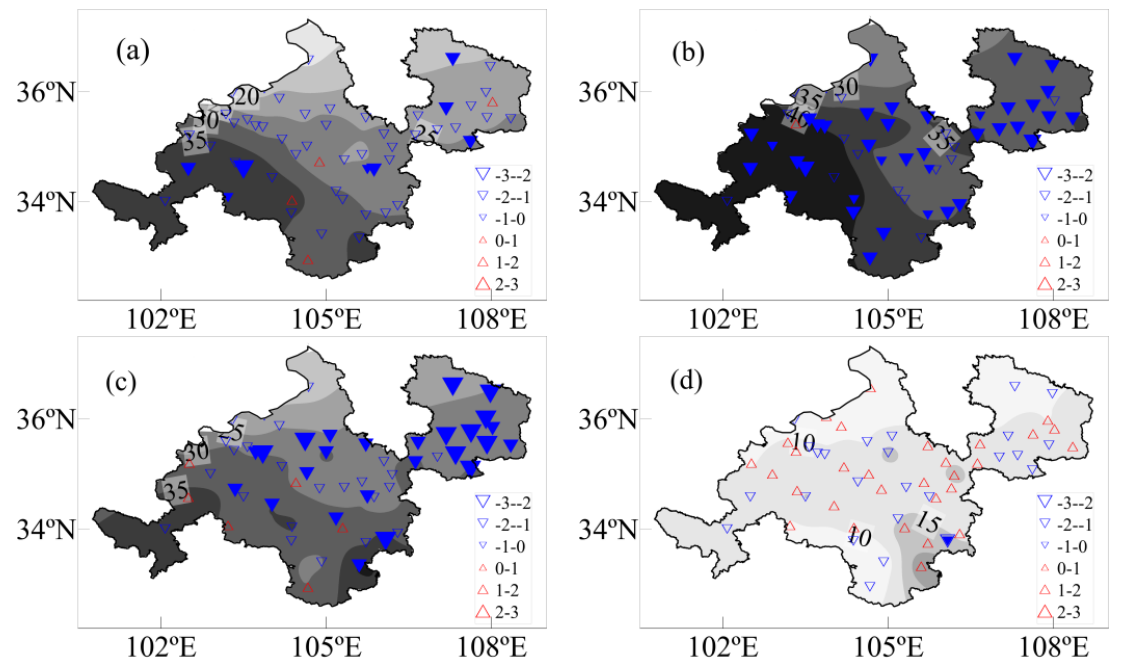
Figure 9. Average days with light and moderate rain and its trend in each season (( a – d ) are spring, summer, autumn, and winter, respectively; solid indicates the trend is significant at the 0.05 level based on the Student’s t